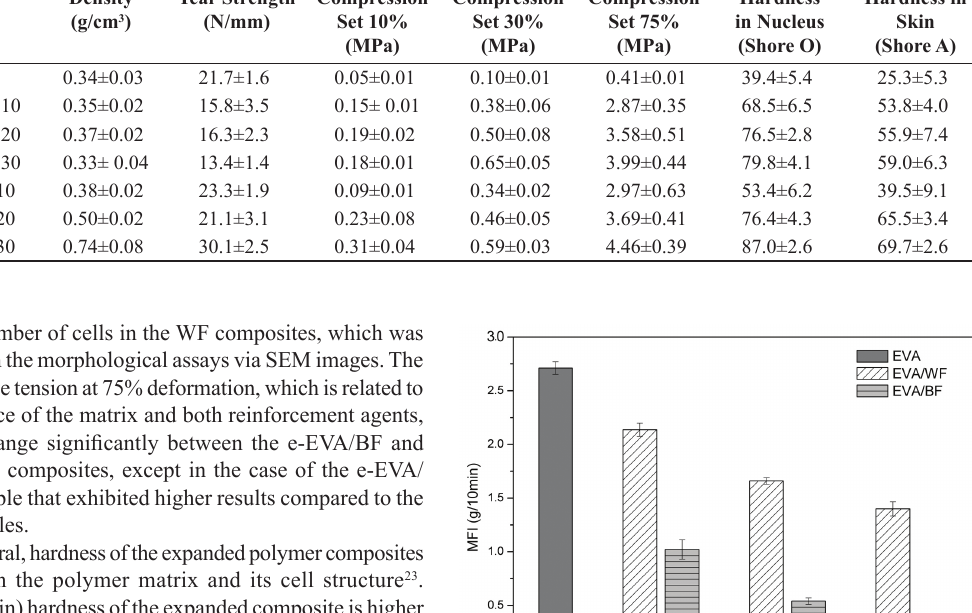
Table 3. Physical and Mechanical properties of the expanded samples. Sample